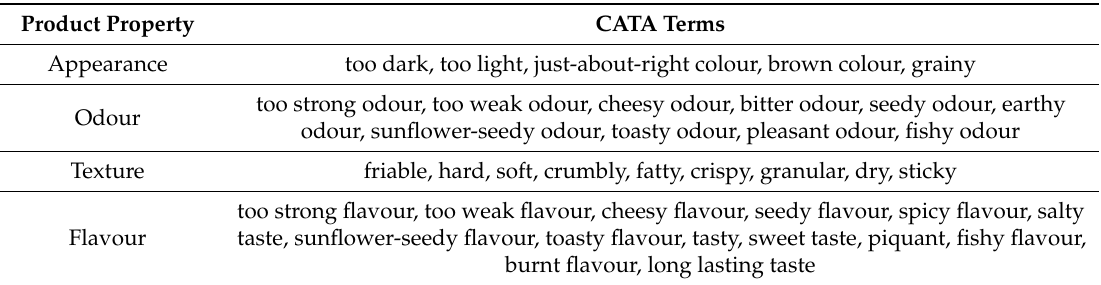
Table 3. Attributes evaluated by consumers using CATA questions for sensory characterization of cricket enriched oat